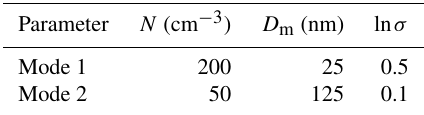
Table 5. Parameter values used in the first set of dynamic model